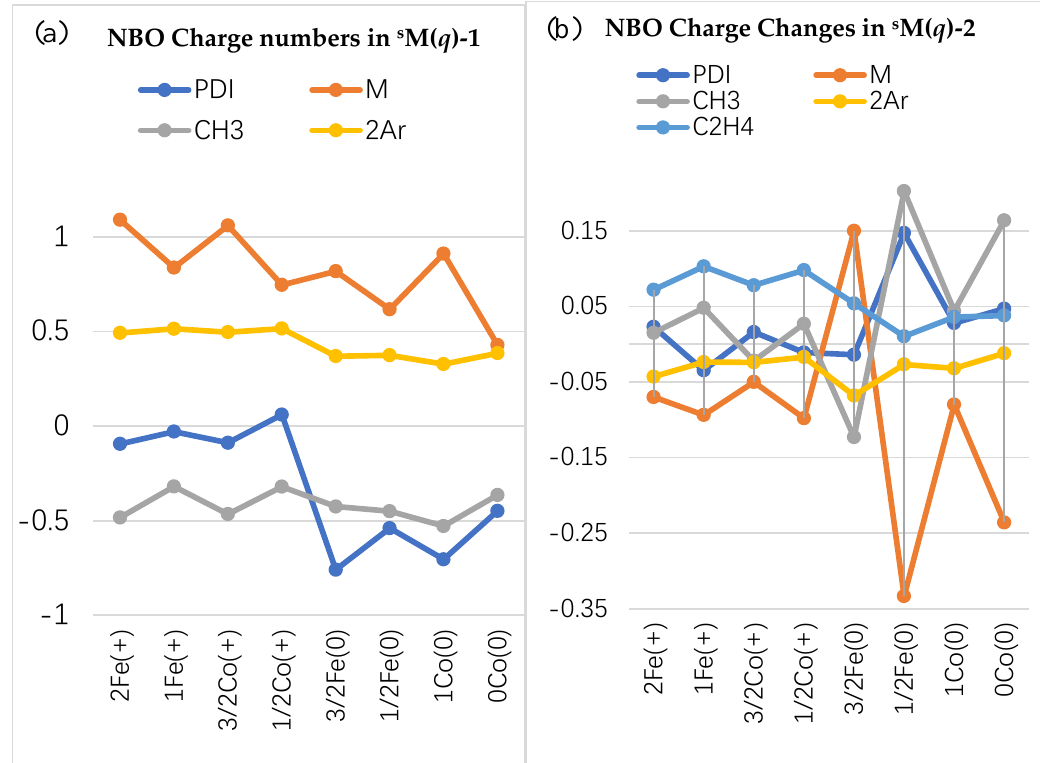
Figure 8. ( a ) The natural bond orbital (NBO) charge distribution for s M( q )-1 and ( b ) the charge changes aroused by ethylene coordination in s M( q )-2 , where M is iron or cobalt, q is zero or positive, with high and low spin states.